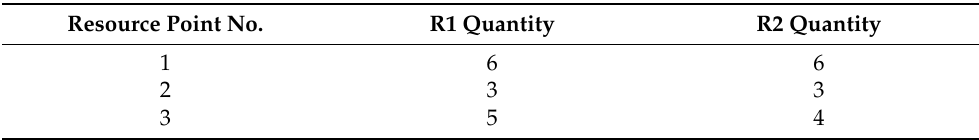
Table 2. Resource types and quantity (Case